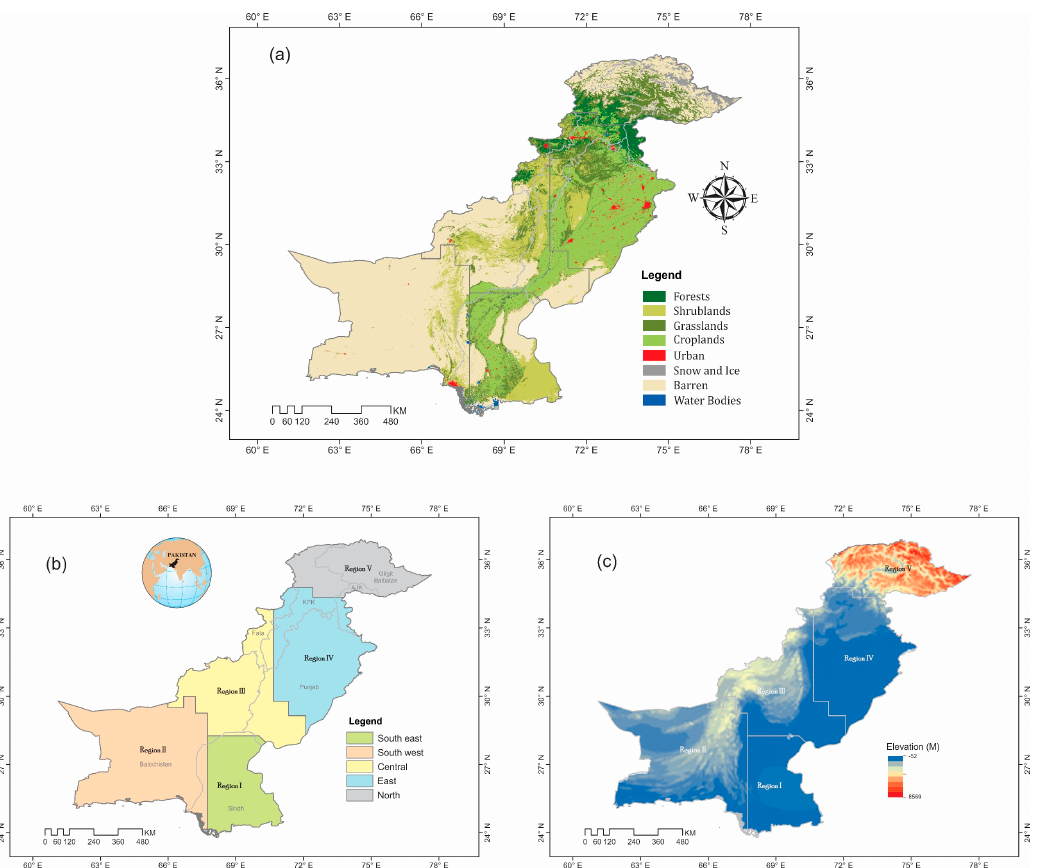
Figure 1. Geographical location of the study region. ( a ) Land cover types in Pakistan during 2019, derived from the MODIS MCD12Q1 Version 6 data product. ( b ) Five homogeneous and contiguous regions were developed, which are similar to the climatic regions developed by [13]. ( c ) Digital Elevation Model based on the ASTER 30 m Digital Elevation Model.